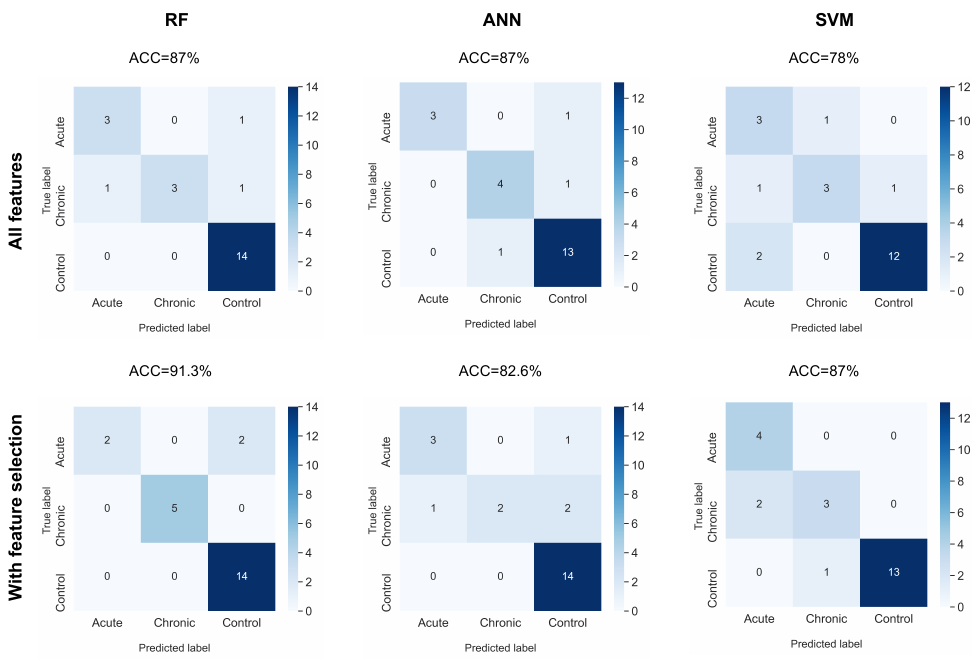
Figure 5. Multiclass classification confusion matrices (Control 1 and 2 vs. the acute group vs. the chronic group) for the final test with hold-out data.